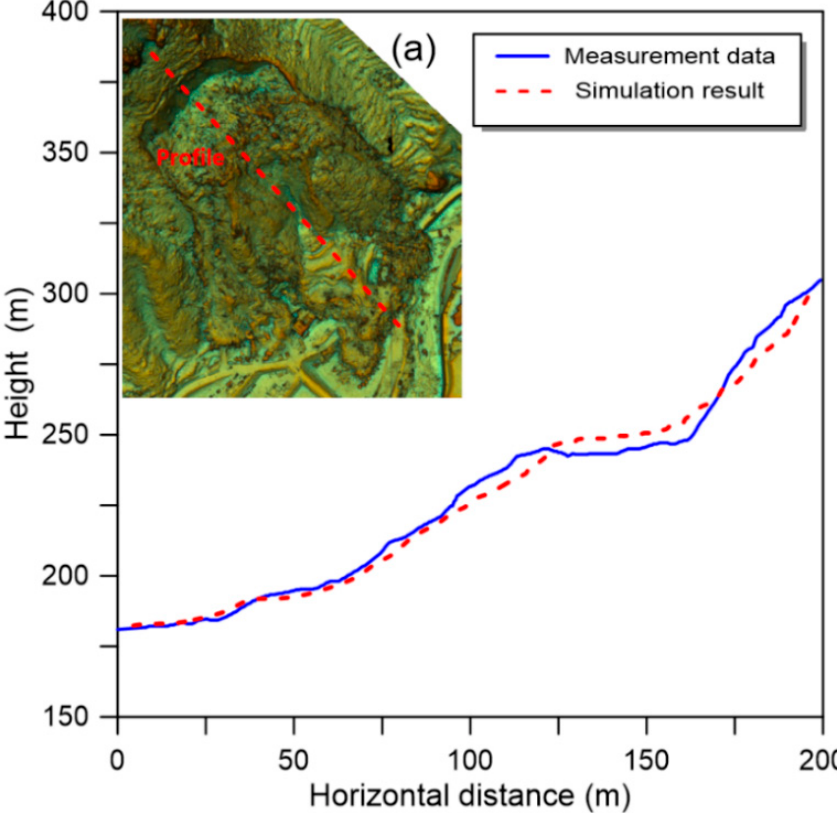
Figure 12. Post-landslide sedimentation profile-comparison between measurement data and numerical simulation.